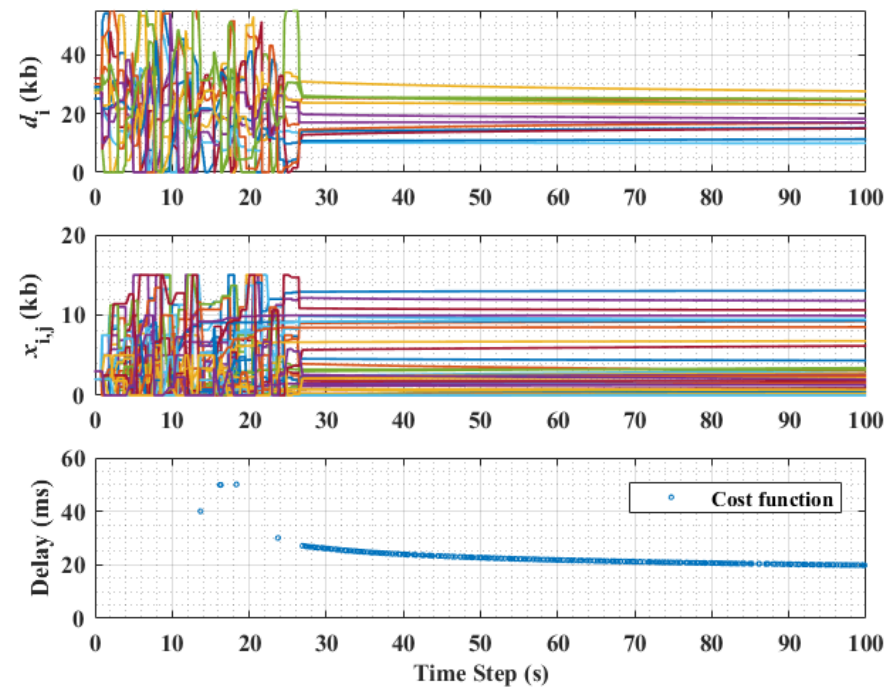
Figure 5. Full mesh topology for probability of 0.1 loss: ( Topmost plot ) Convergence of the transmitted messages. ( Middle plot ) Evolution of traffic x i , j on each path. ( Lower plot ) The objective cost delay function.